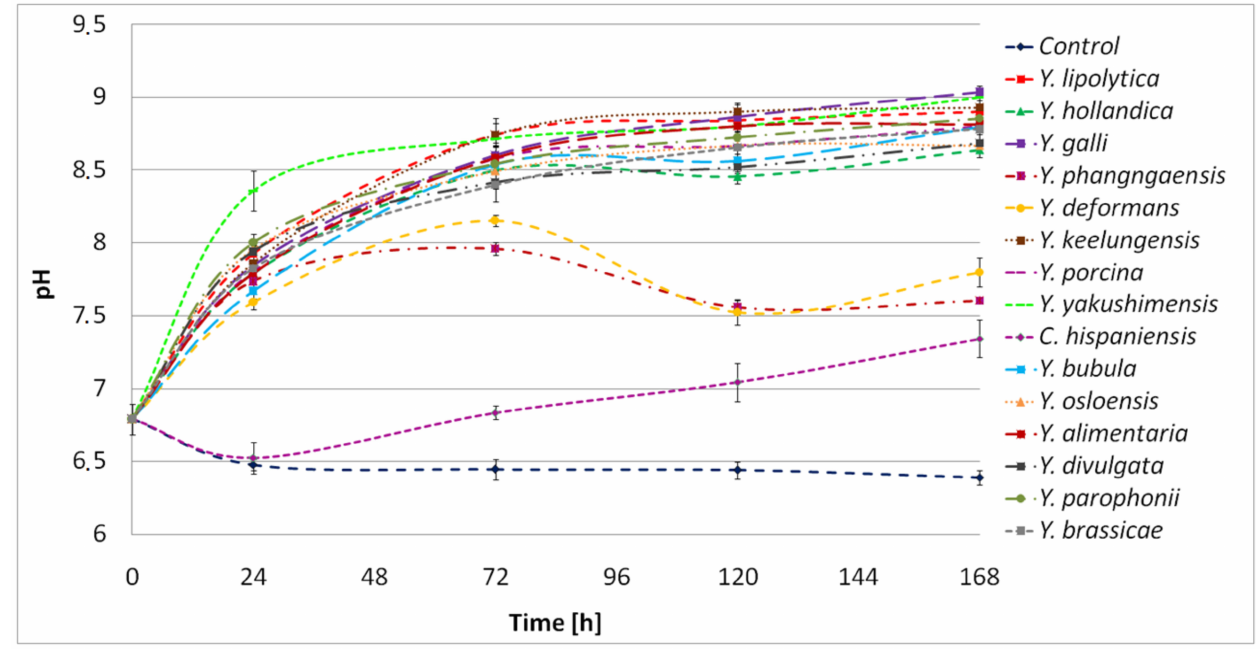
Figure 8. Kinetics of pH in the Yarrowia clade culture performed in BSG medium as a function of time. The results are presented as mean values ± SD. n =